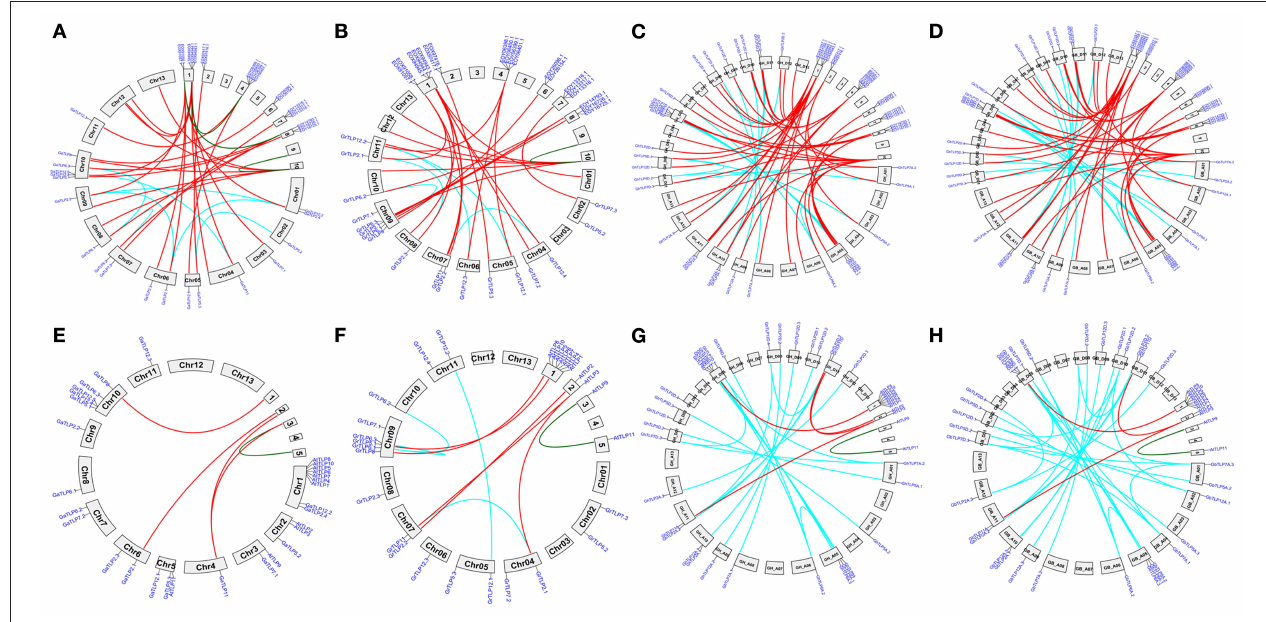
FIGURE 2 | Synteny analysis of cotton TLP genes with T. cacao (Malvaceae) and A. thaliana (Brassicaceae) genomes. A syntenic representation of the identified TLP genes between (A) G. arboreum (Chr01 to Chr13) vs. T. cacao (B) G. raimondii (Chr01 to Chr13) vs. T. cacao (C) G. hirsutum (At1 to At13 and Dt1 to Dt13) vs. T. cacao (1–10) (D) G. barbadense (At1 to At13 and Dt1 to Dt13) vs. T. cacao (1–10) (E) G. arboreum (Chr01 to Chr13) vs. A. thaliana (F) G. raimondii (Chr01 to Chr13) vs. A. thaliana (G) G. hirsutum (At1 to At13 and Dt1 to Dt13) vs. A. thaliana (H) G. barbadense (At1 to At13 and Dt1 to Dt13) vs. A. thaliana chromosomes. Red lines indicate duplicated orthologous TLP genes, and cyan and green lines show the paralogous TLPs genes in G. hirsutum, G. raimondii, G. arboreum, T. cacao , and A. thaliana .